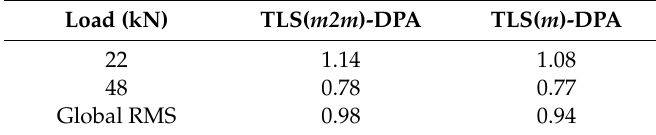
Table 7. RMS (mm) of each TLS methodology with DPA beam#1 LC2.